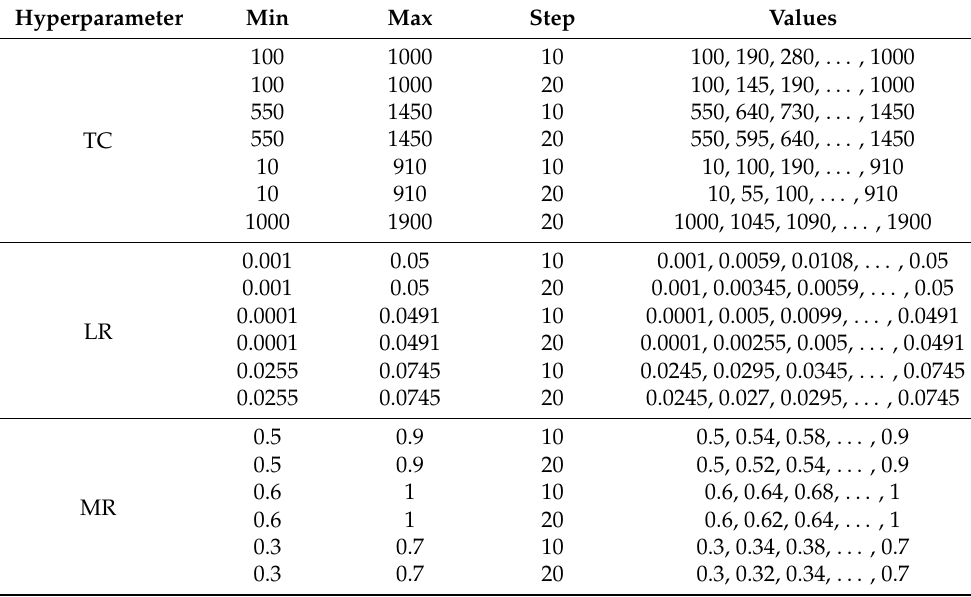
Table 4. Values of ANN hyperparameters in the sequential grid